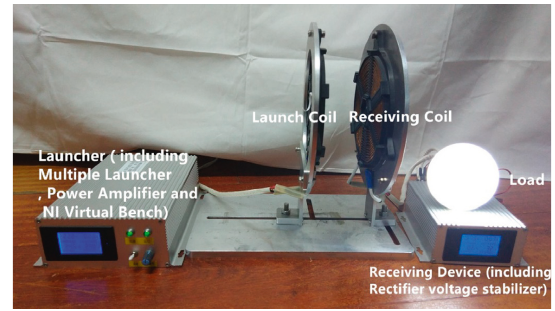
Figure 14: Experimental setup of the proposed MCRETS system.